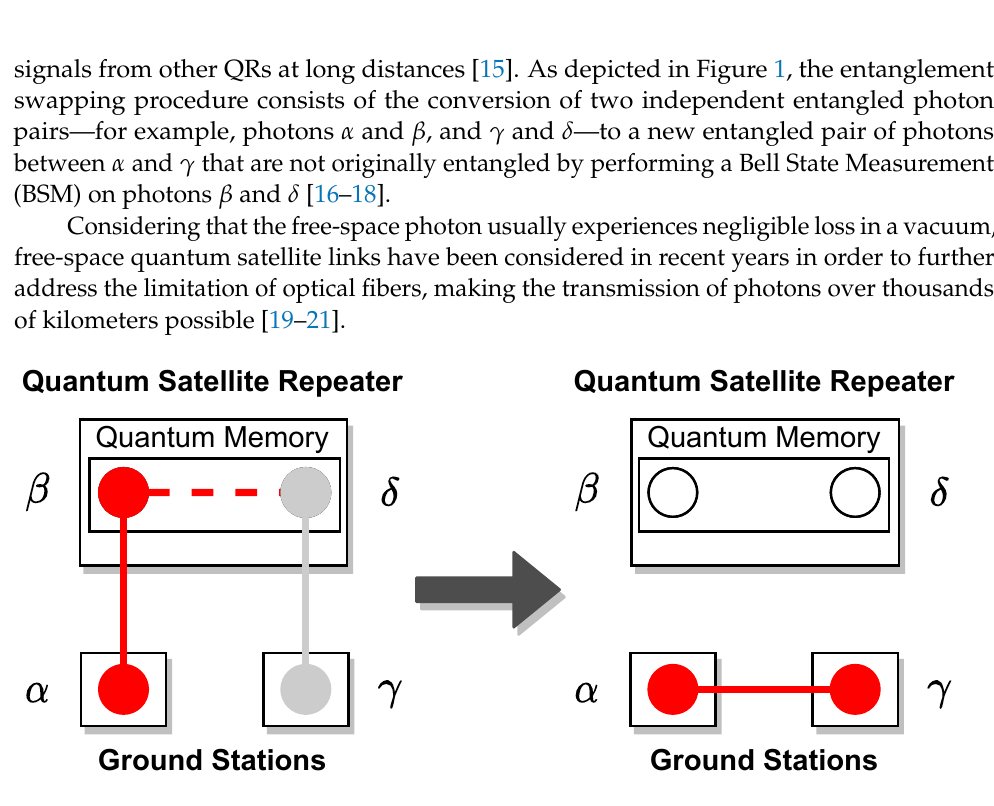
Figure 1. Entanglement swapping performed by a quantum satellite